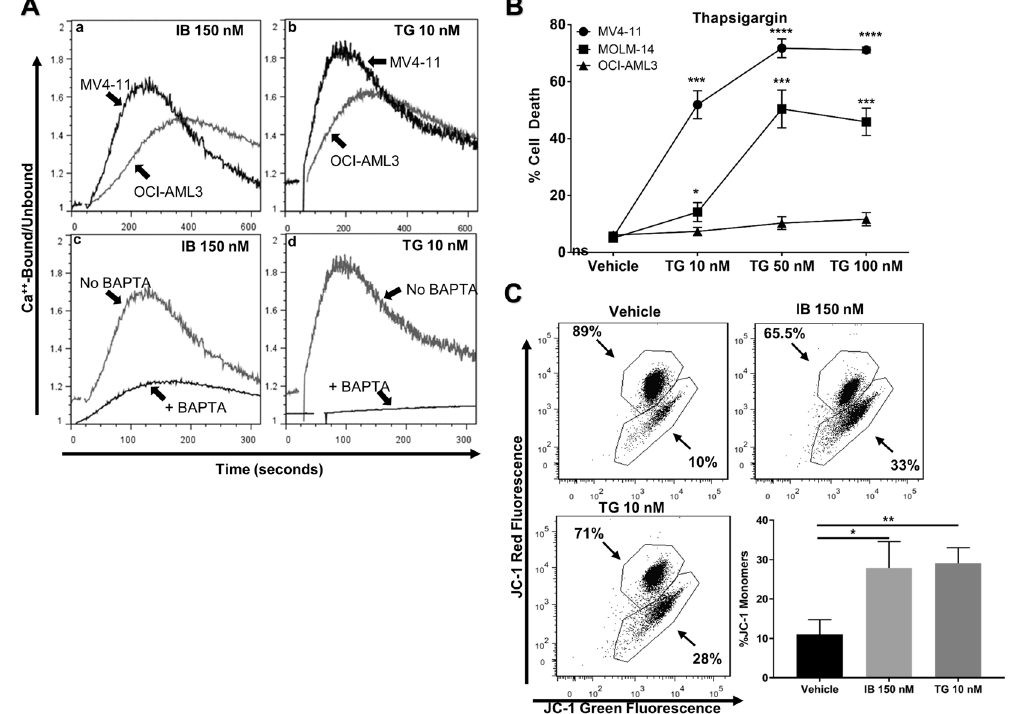
Figure 5. Low dose imipramine blue-mediated calcium induced cell death and both imipramine blue and thapsigargin are potent inducers of mitochondrial outer membrane permeabilization. ( A ) (Representative result of n = 3) Indo-1 cytoplasmic Ca 2 + assay. IB and TG caused Ca 2 + release in OCI-AML3 cells to a lesser extent (a,b). In MV4–11 cells, IB and TG demonstrated an influx of cytoplasmic Ca 2 + that was reversed by the addition of 5 μ M BAPTA (c, d) ( B ) Trypan blue exclusion assay after 48 hours of drug treatment showed that TG has a similar selective cytotoxicity profile as IB for FLT3/ITD + cell lines, implicating Ca 2 + release in the mechanism of cell death. ( C ) JC-1 assay demonstrated a significant increase in JC-1 monomers after 18 hours of drug treatment with IB or TG in MV4–11 cells. ( * p < 0.05, ** p < 0.01, *** p < 0.001, **** p < 0.0001, ns: p >